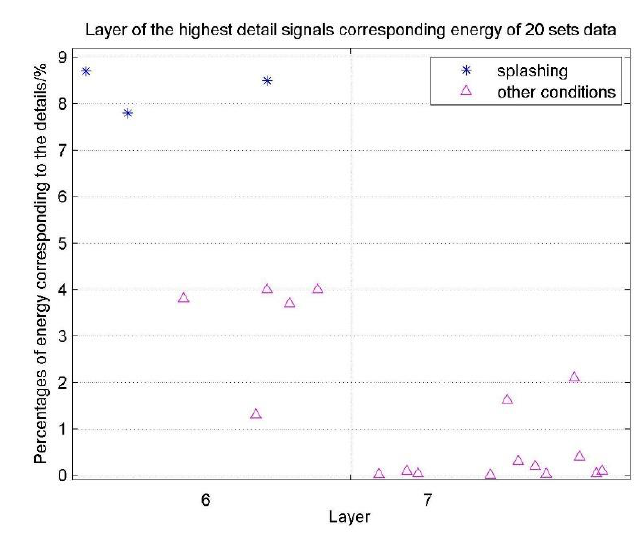
Figure 8. Layer of the highest detail signal ’ s corresponding energy of 20 sets of data.